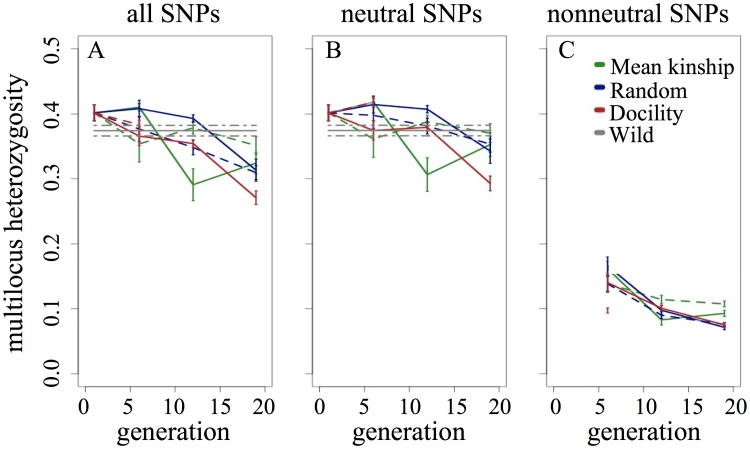
Effects of inbreeding, drift, and selection in captive populations.Mean multilocus heterozygosity (MLH) for six captive populations and the wild source population. Replicate populations are shown by solid (replicate 1) and dashed (replicate 2) lines. Estimates are shown for all genotyped SNPs (A), neutral SNPs (B) and nonneutral SNPs (C) as determined via simulations. Error bars represent SE calculated across individual estimates.